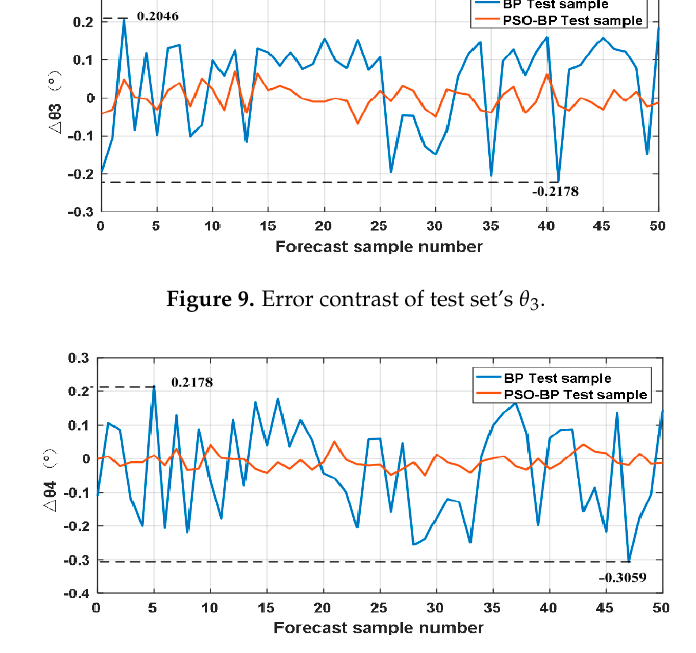
Figure 10. Error contrast of test set’s θ 4 .